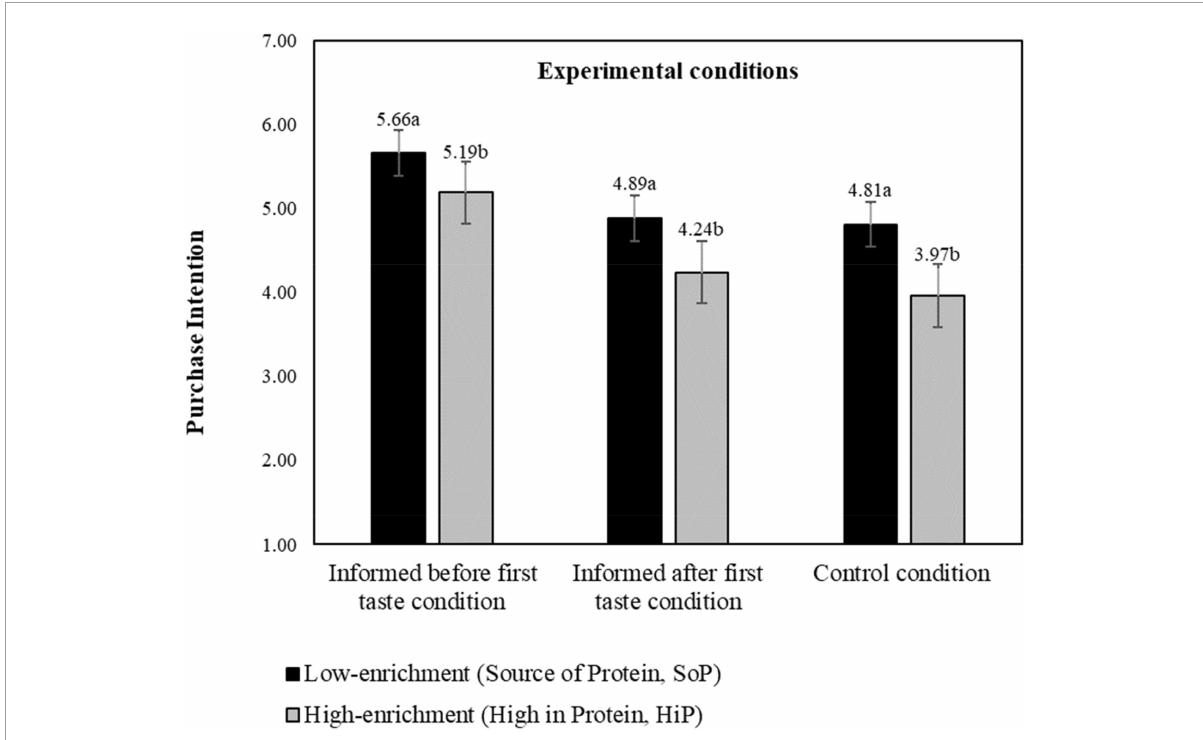
FIGURE7 Interaction effect of experimental conditions and level of product protein-enrichment on purchase intention, estimated marginal means. a,b: means with different letters are significantly different at p < 0.05 level; purchase intention measured on a 11-point probability scale. The bars display standard